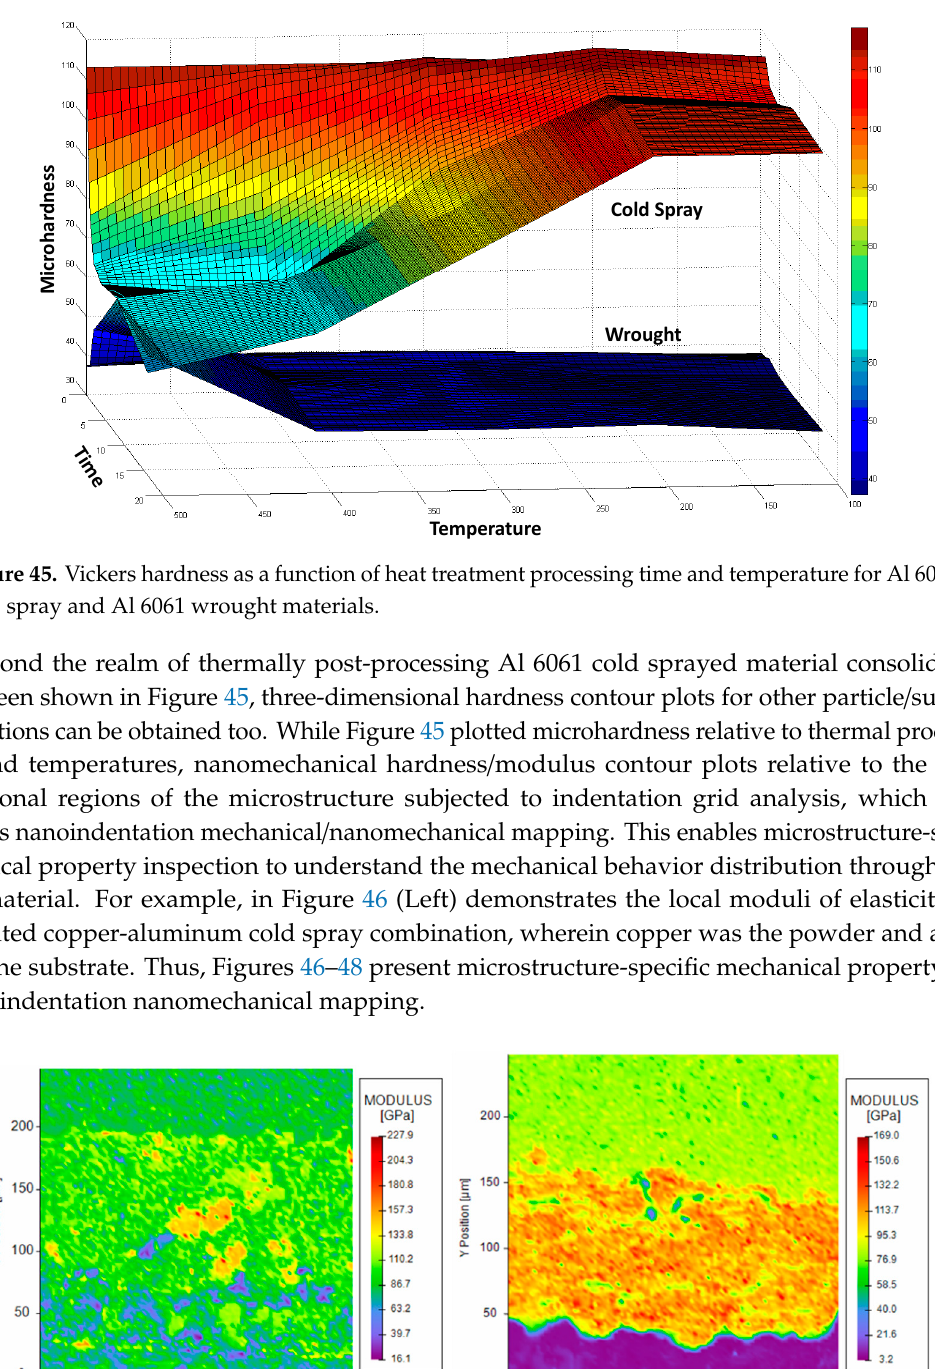
of elasticity contour plot ( Right ). A di ff usion zone clearly formed and multiple intermetallic compounds developed at the particle / substrate interfacial region ( Left ). Note that the mounting material is also captured in ( Right ) as the purple region, whereas the red / orange / yellow region is the copper coating and the yellow / green region is the substrate. Similarly, between the ( Left ) “Y Position” value of 200 to 250 µ m is just the substrate